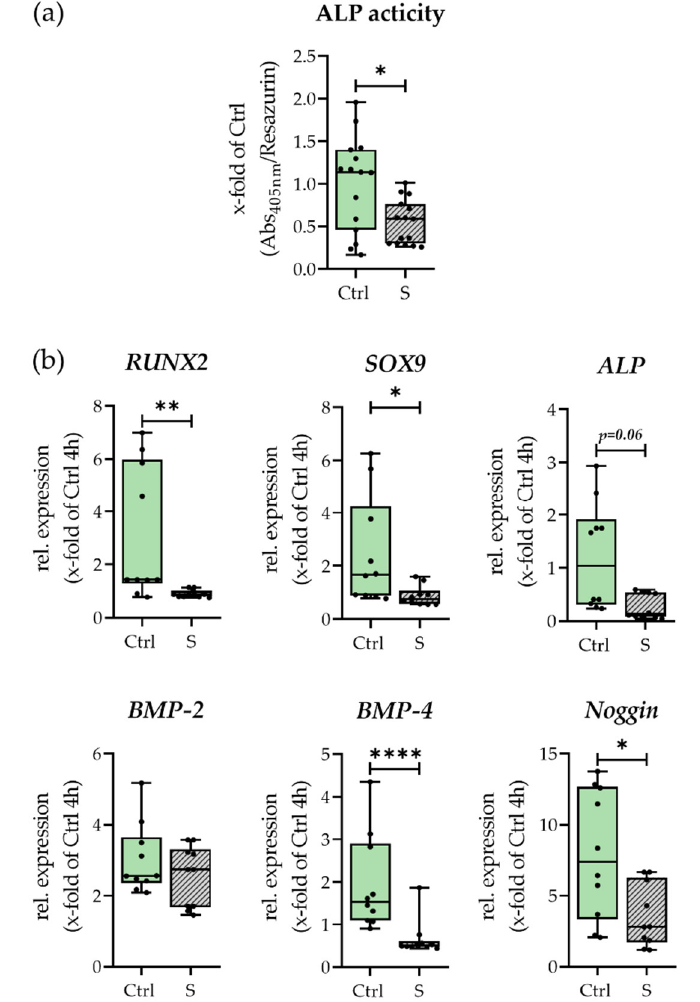
Figure 4. Osteogenic and chondrogenic differentiation potential of smokers’ (S) and non-smokers’ (Ctrl) in vitro fracture hematomas. With ( a ) ALP activity after 48 h. N = 5, n = 3. ( b ) Expression of RUNX2, SOX9, ALP, BMP2, BMP4, and Noggin after 48 h. N = 5, n = 2. * p < 0.05, ** p < 0.01, **** p < 0.0001.